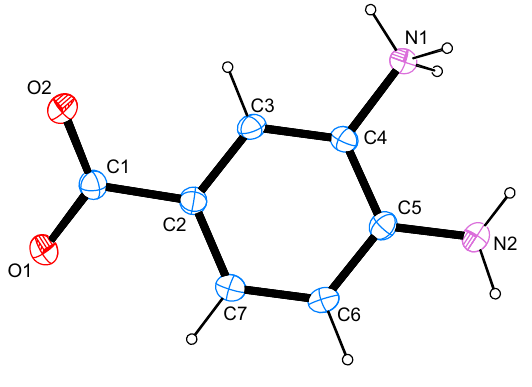
Table  : Data collection and